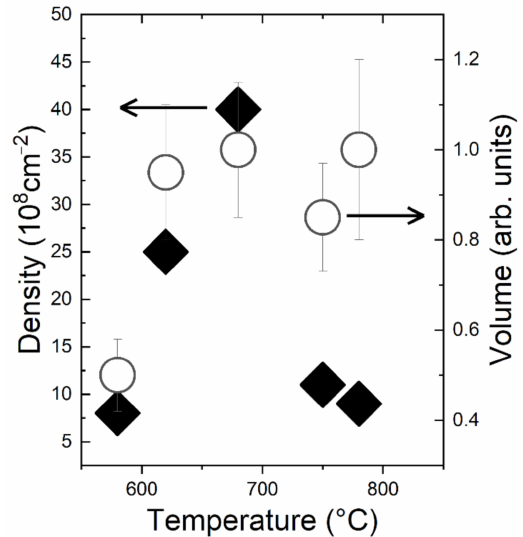
Figure 4. Temperature dependence of the ensemble island density (black diamonds) and ensemble island volume (white circles). The island volume is estimated through the formula V ISL = η d 3 , where d is the island diameter and η an undetermined constant which depends on the actual island